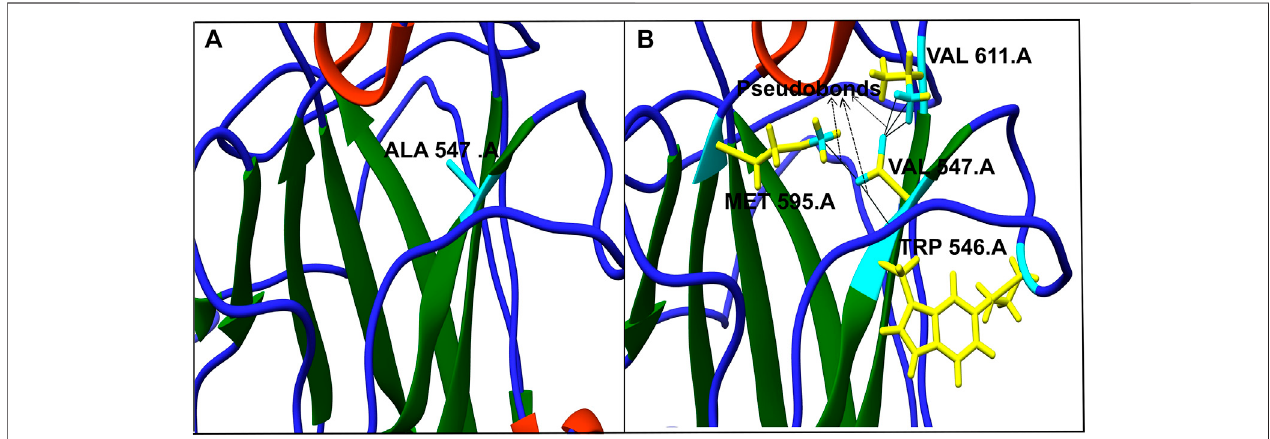
FIGURE 3 | Effect of single nucleotide variation rs764770086 (A547V) on protein ’ s 3D structure. Alanine at position 547 (cyan) in wild protein forms no contacts in native form (A) whereas Valine at the same position (yellow and cyan) forms fi ve new contacts with Val611, Met595, and Trp546 (B) . The networks of clashes or new pseudobonds are shown as black